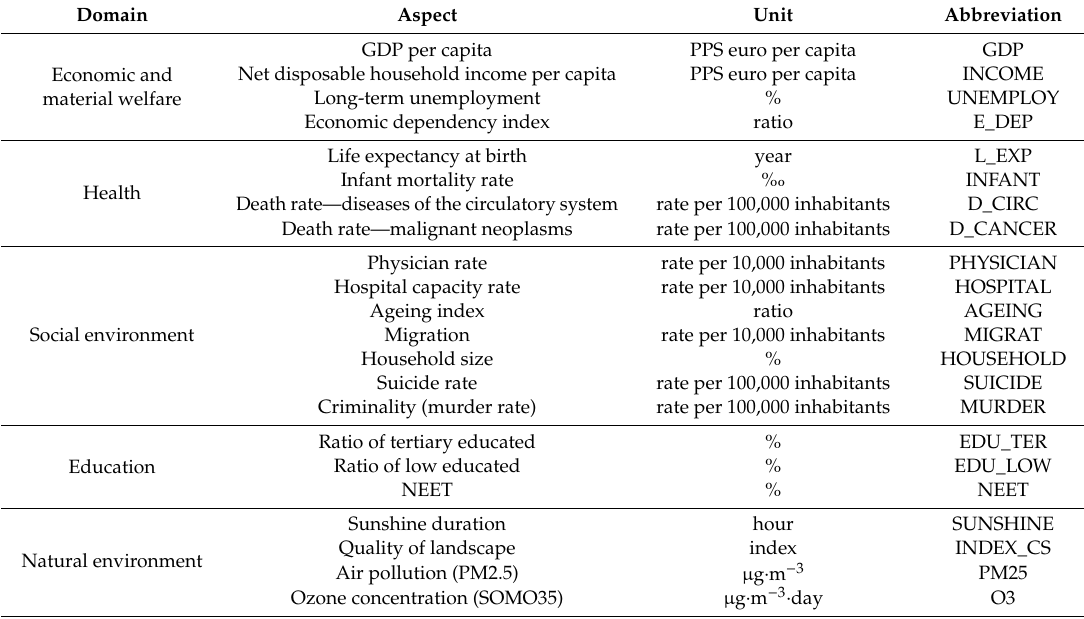
Table 1. Overview of the core quality of life domains and their